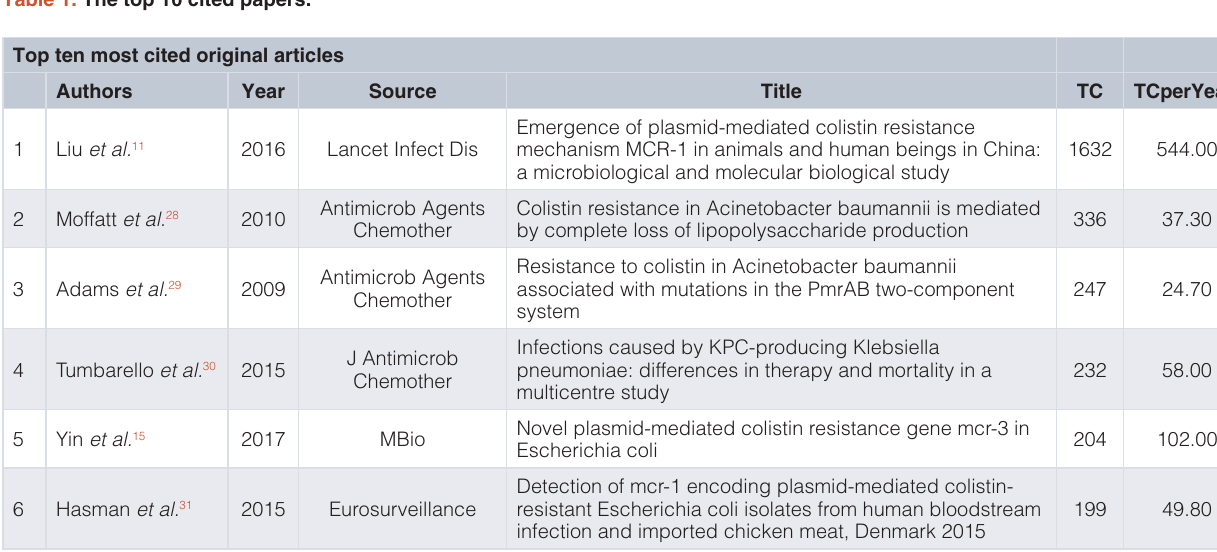
Table 1. The top 10 cited